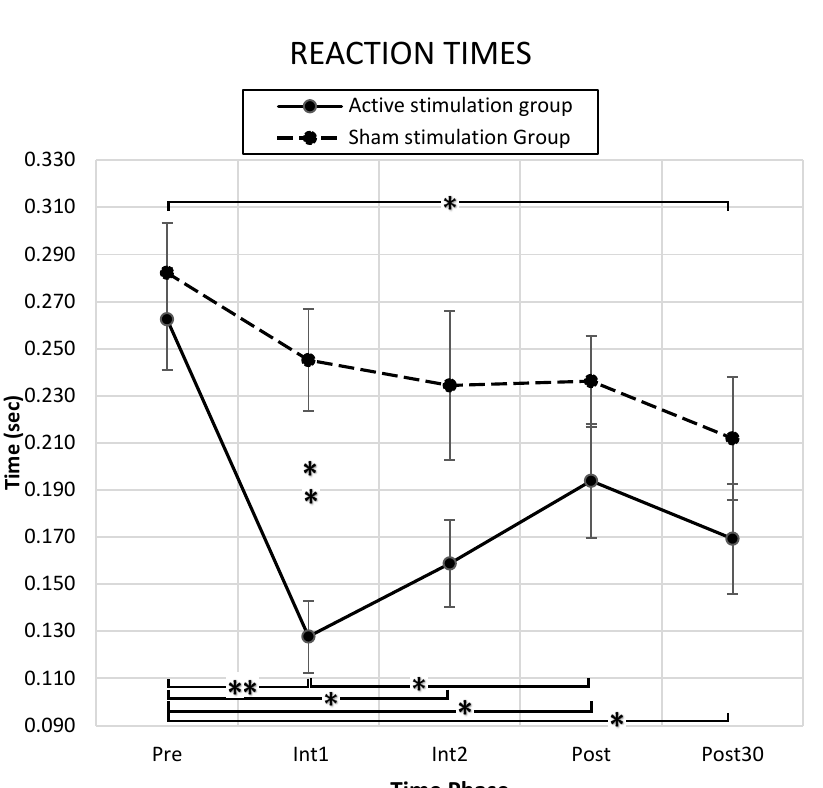
Figure 3. RT assessments . Mean and SE of the elapsed time from the cue until the first movement, defined as RT, for Active and Sham groups at each experimental time point: Pre-Assessment (Pre), first intervention block (Int1), second intervention block (Int2), Post-Assessment time (Post), Post-30’-Assessment (Post30). * corresponds to significance between p = 0.05 and p = 0.01; ** correspond to significance below p = 0.01.